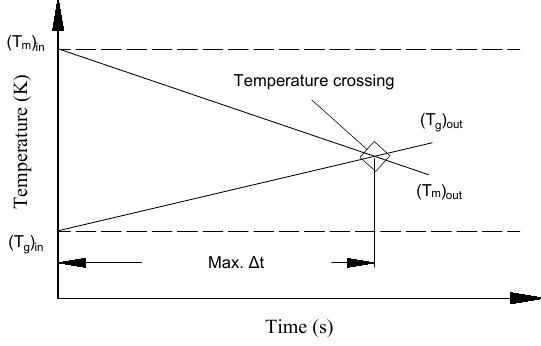
Figure 3. Convergence criteria for the numerical model during the cooling period.